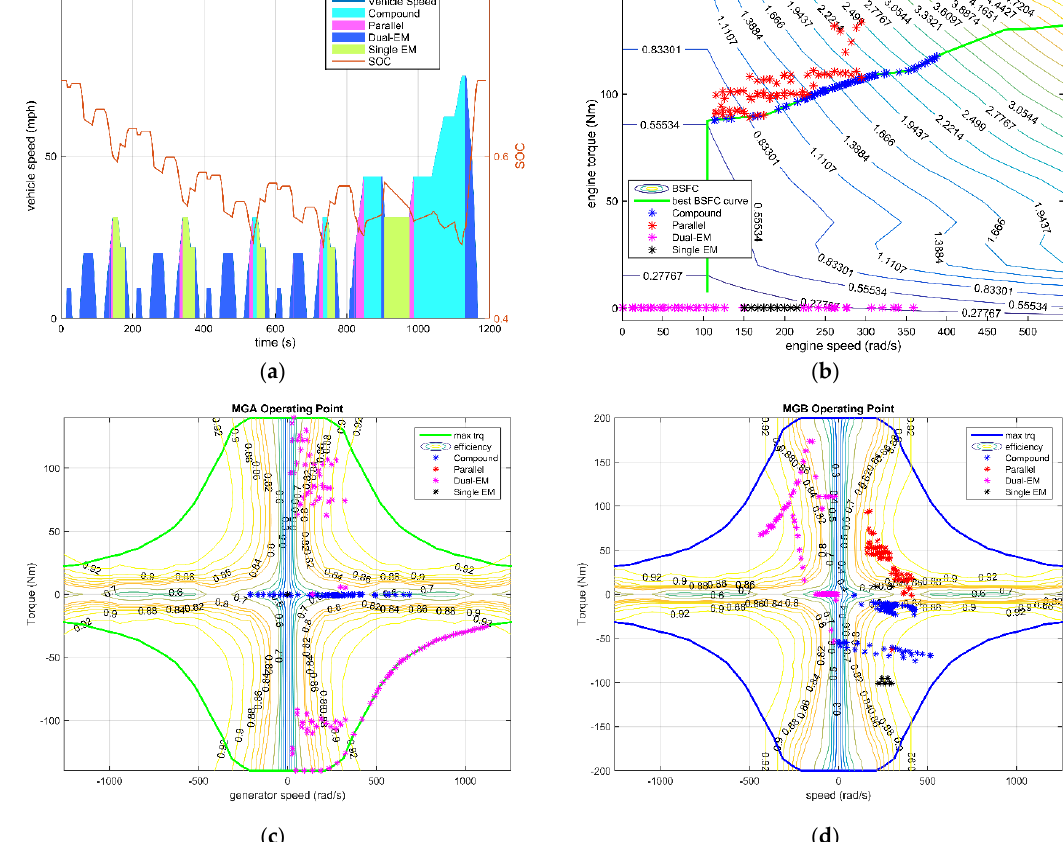
Figure 10. ( a ) Battery SoC trajectory and mode selection over the NEDC drive cycle; ( b ) engine optimal operation points over the NEDC drive cycle; ( c ) EMA operating points over the NEDC drive cycle; ( d ) EMB operating points over the NEDC drive cycle.